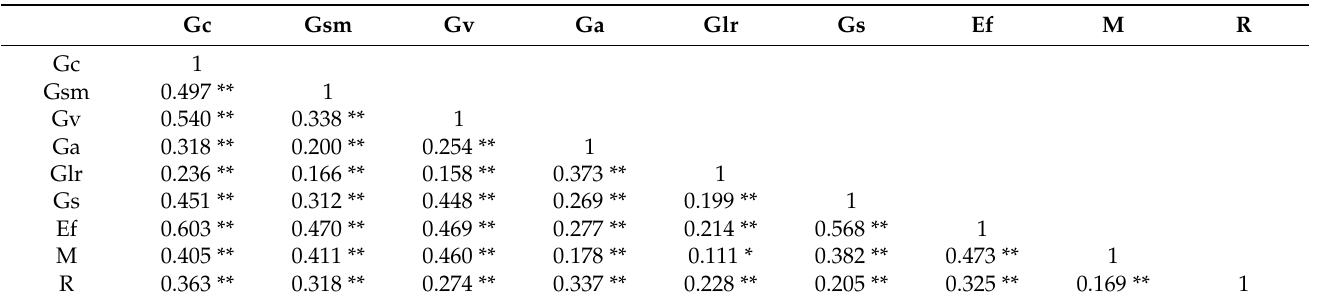
Table 2. The cognitive abilities of Chinese students in grades 1 to 6 are related to their Chinese mathematics